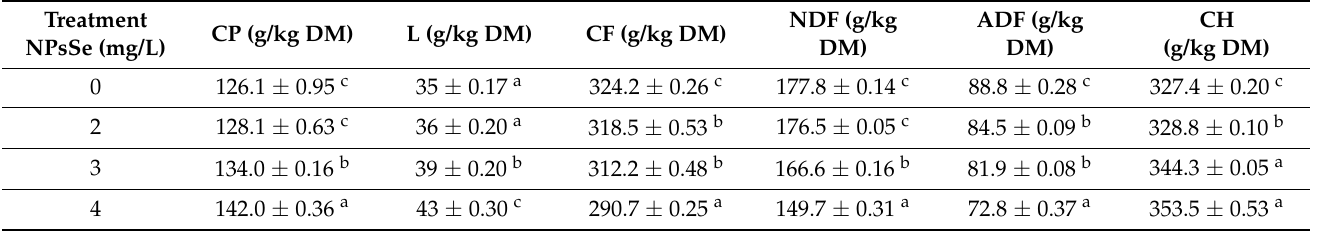
Table 2. Nutritional parameters of Festuca arundinacea Schreb. bio-fortified via foliar with different concentrations of Selenium